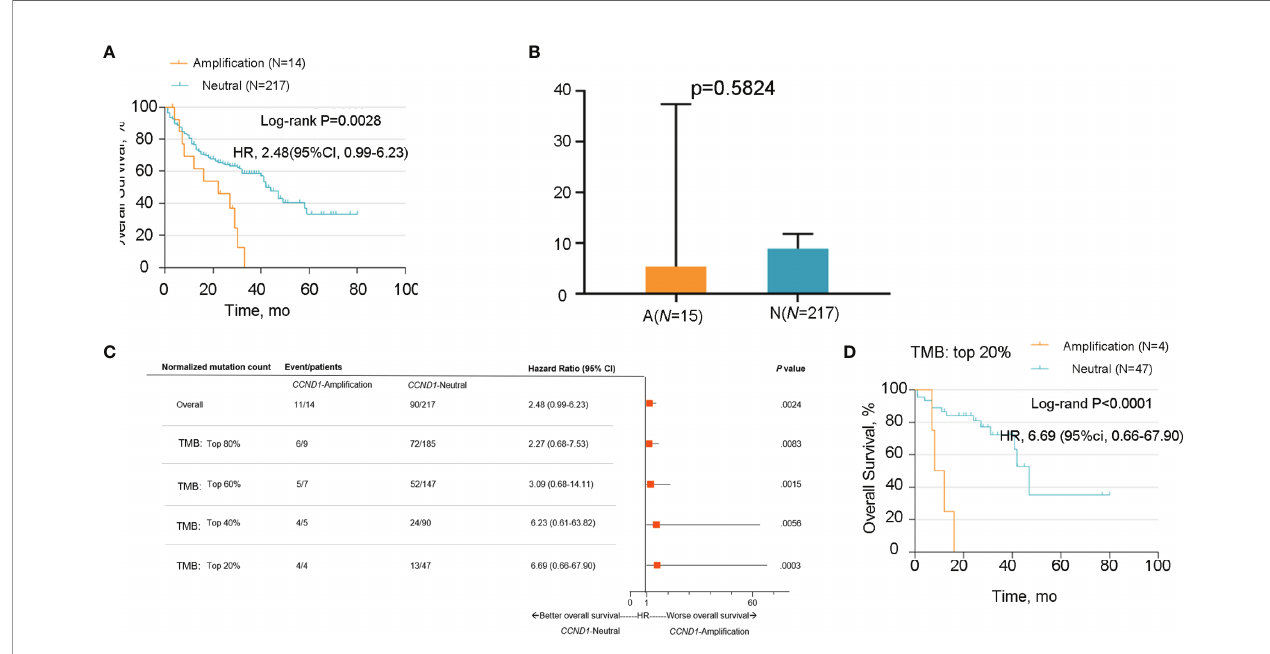
FIGURE 3 | Association between survival and CCND1 ampli fi cation in melanoma patients after treatment with ICIs in the MSKCC-IO cohort ( n =231). (A) The relationship between survival and CCND1 ampli fi cation in the MSKCC-IO cohort. (B) The correlation between TMB and CCND1 ampli fi cation in samples from patients with melanoma included in the MSKCC-IO cohort ( n =232). (C) Hazard ratio of CCND1 status across melanoma patients with different level of TMB in the MSKCC-IO cohort ( n =232). (D) Kaplan-Meier survival analysis of melanoma patients in the top 20% TMB within each histology in the MSKCC-IO TMB-high subgroup ( n =51). a The MSKCC-IO cohort included data from patients in the MSKCC database who had received at least one dose of ICIs. ICI, immune checkpoint inhibitor; MSKCC, the Memorial Sloan Kettering Cancer Center; TCGA, The Cancer Genome Atlas; TMB, tumor mutation